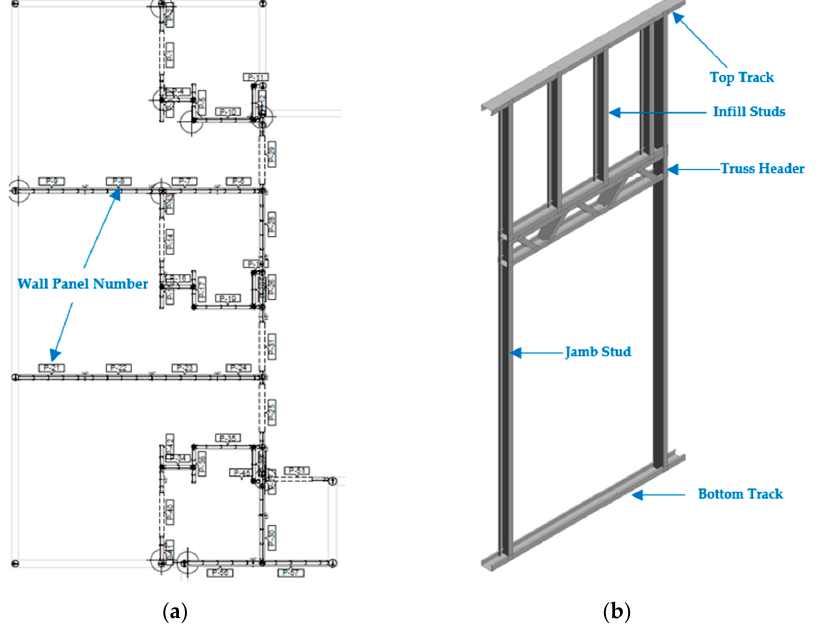
Figure 3. ( a ) Example of wall layout for panelization; ( b ) three-dimensional model of a wall panel.